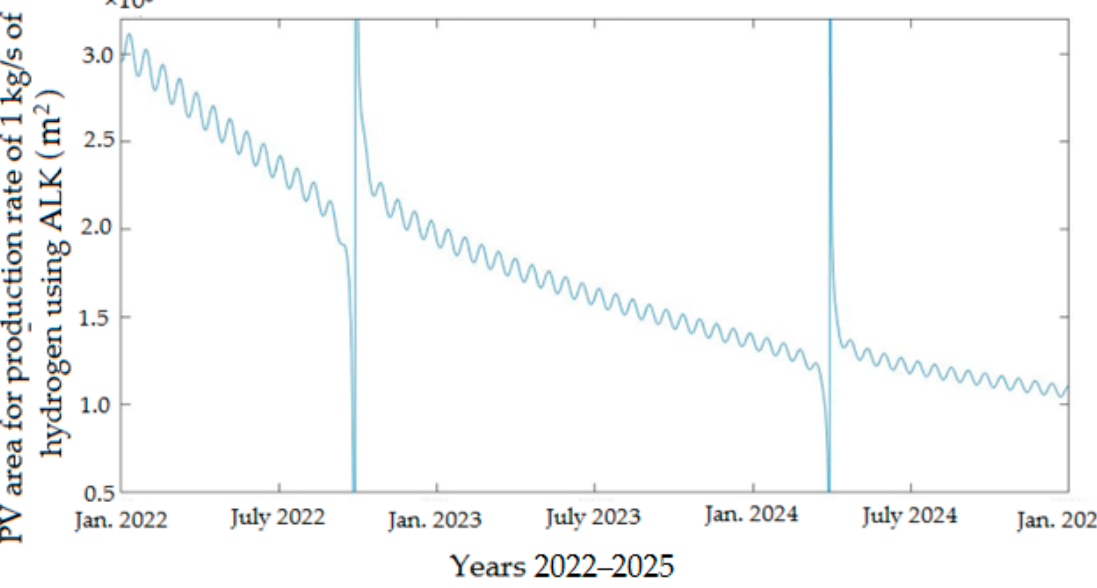
Figure 6. Forecasting the PV area required to produce 1 kg/s of hydrogen using an ALK electrolyzer during 2022–2025.